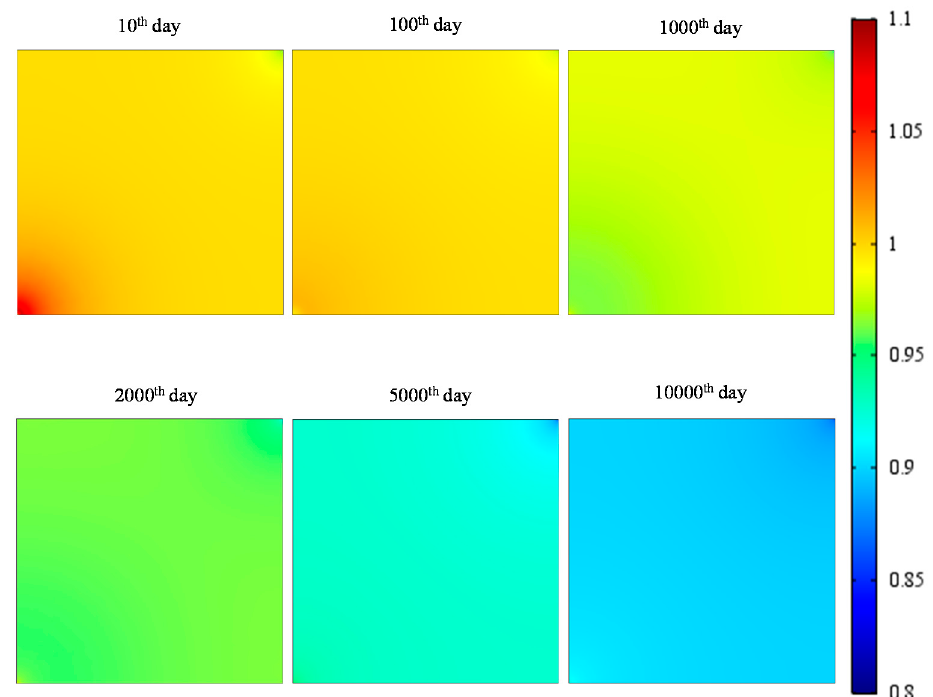
Figure 4. Matrix permeability evolution maps ( k m / k m 0 ) at different time.